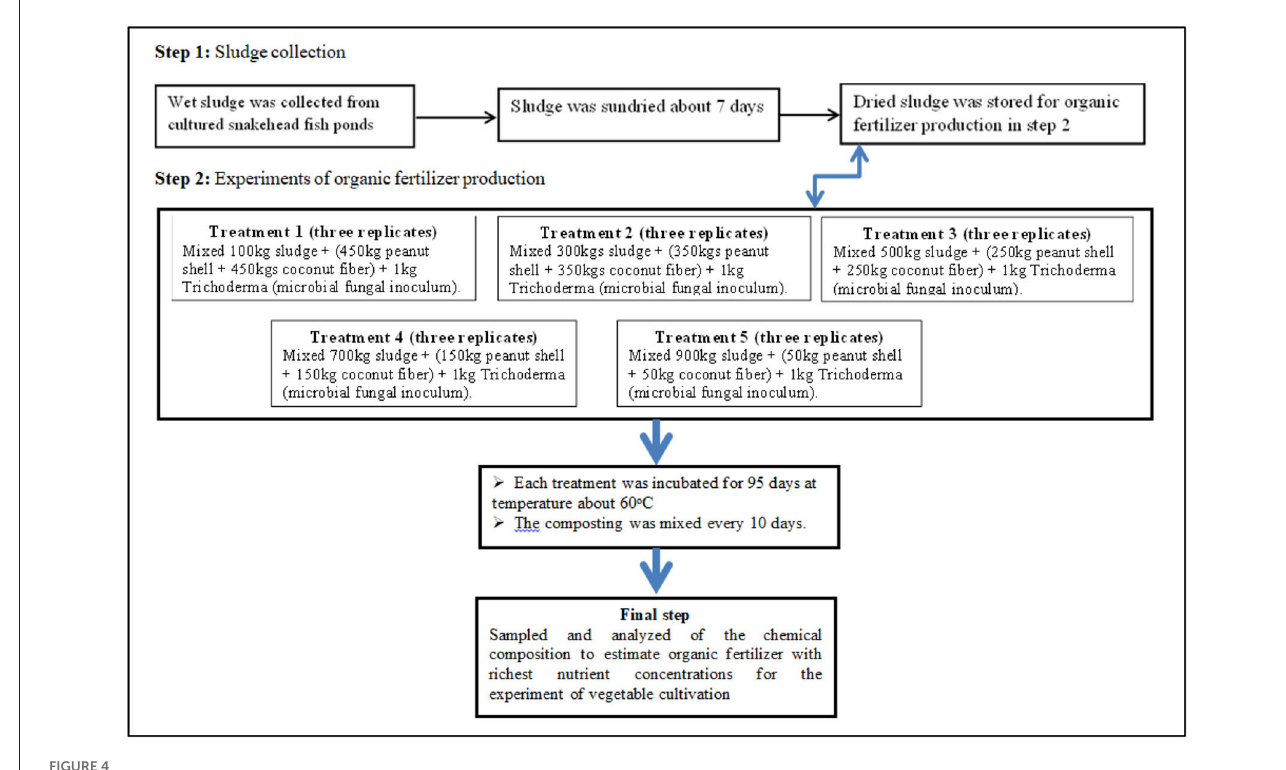
FIGURE4 Layout of the compositing method applied and used in experimental organic fertilizer production (Hien, 2003).